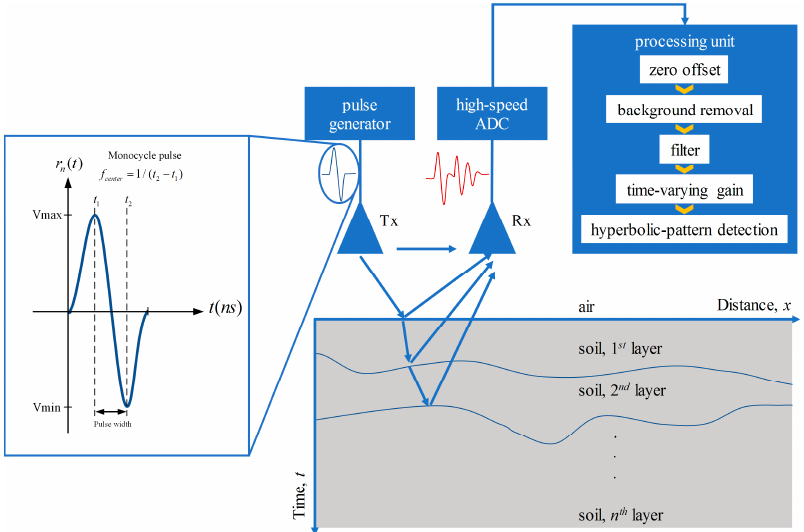
Figure 1. Basic concept and configuration of the GPR system along with signal processing.